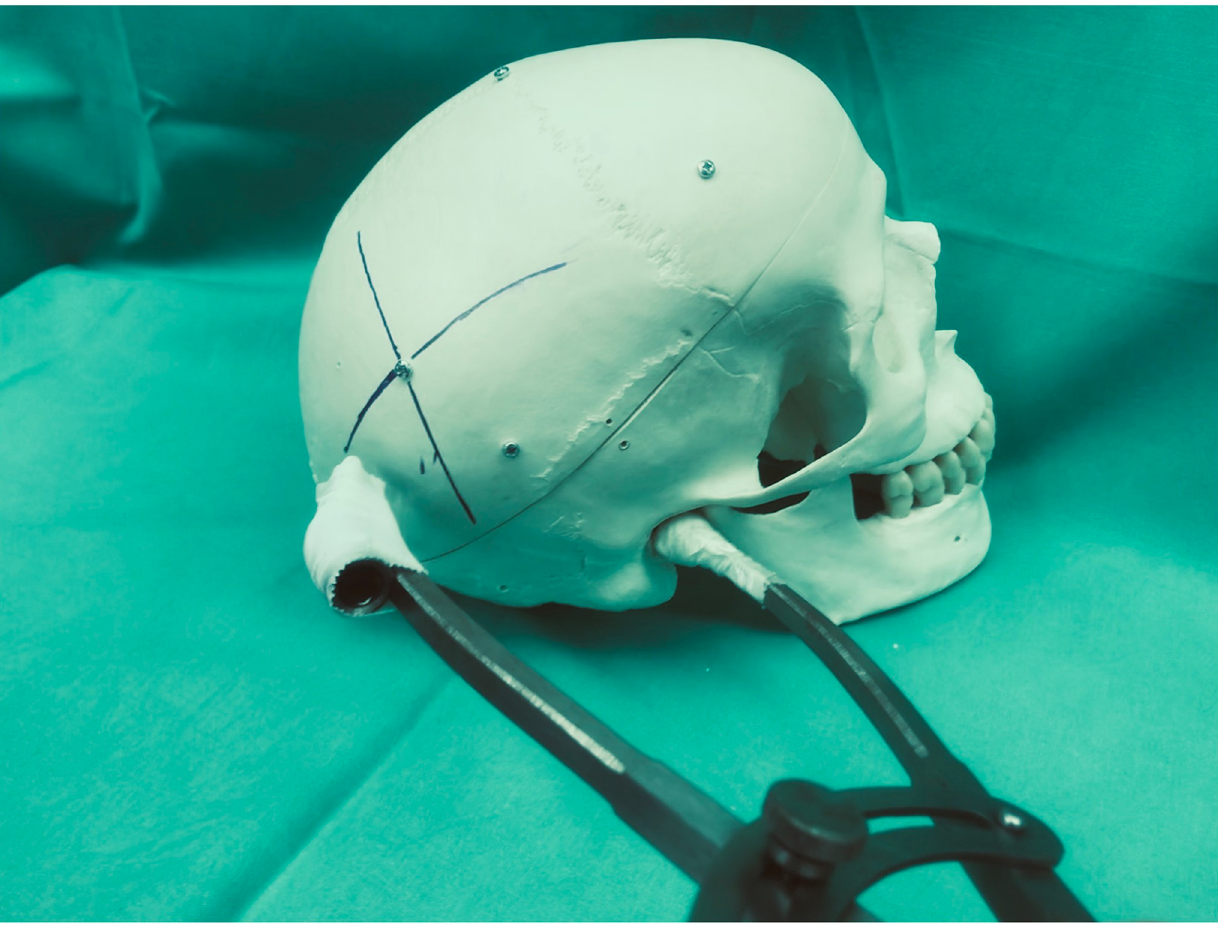
Fig 4. Example of the localization of one of the 20 targets on the saw bone model. The intersection of the two circles meets at the target.